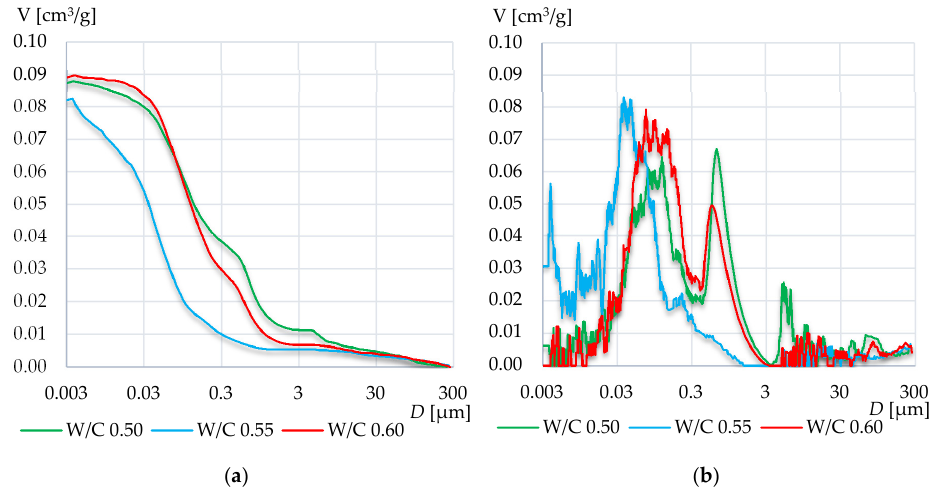
Figure 9. Cumulative distribution volume ( a ) and log ‐ differential pore distribution ( b ) graphs of the mortars based on CEM I 42.5R.